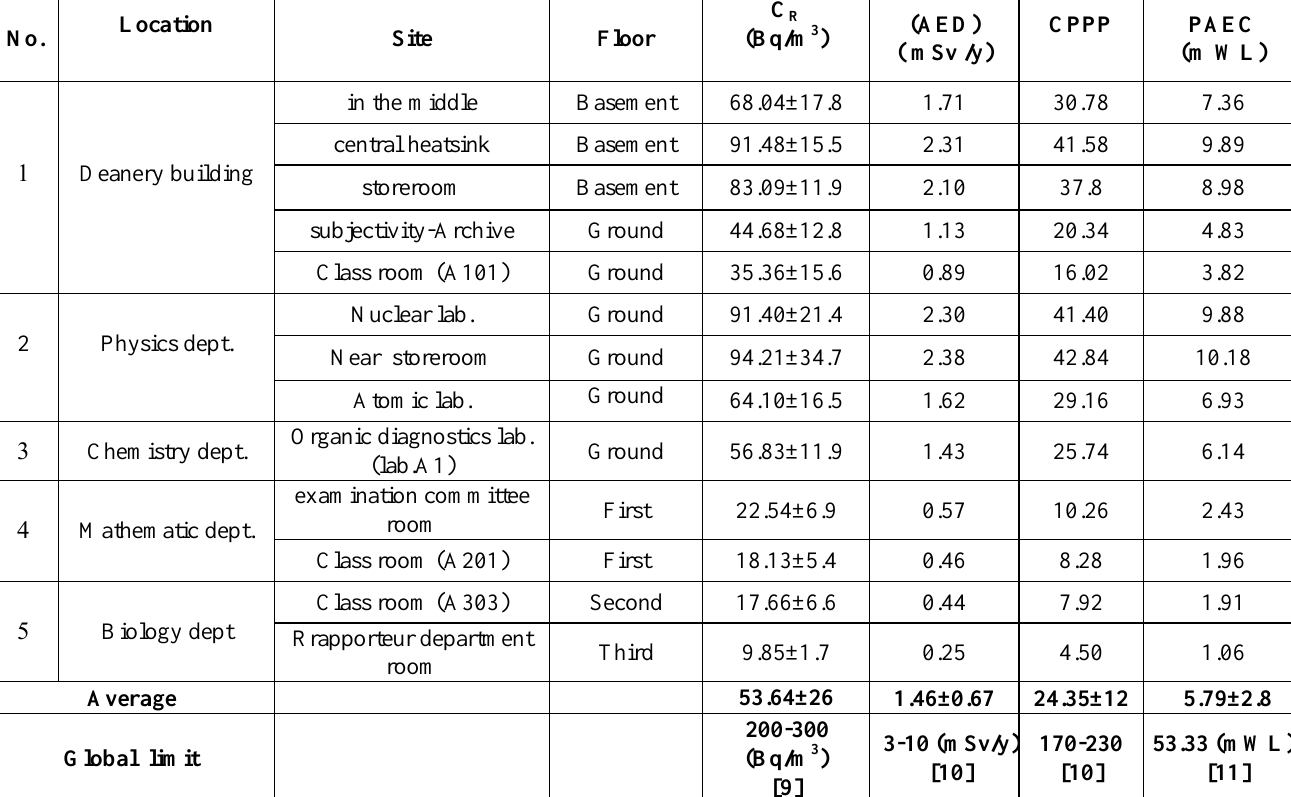
Table 1: Radon gas concentration, the annual effective dose (A.E.D), lung cancer cases per year per million person (CPPP), the potential alpha energy concentration (PAEC). No.